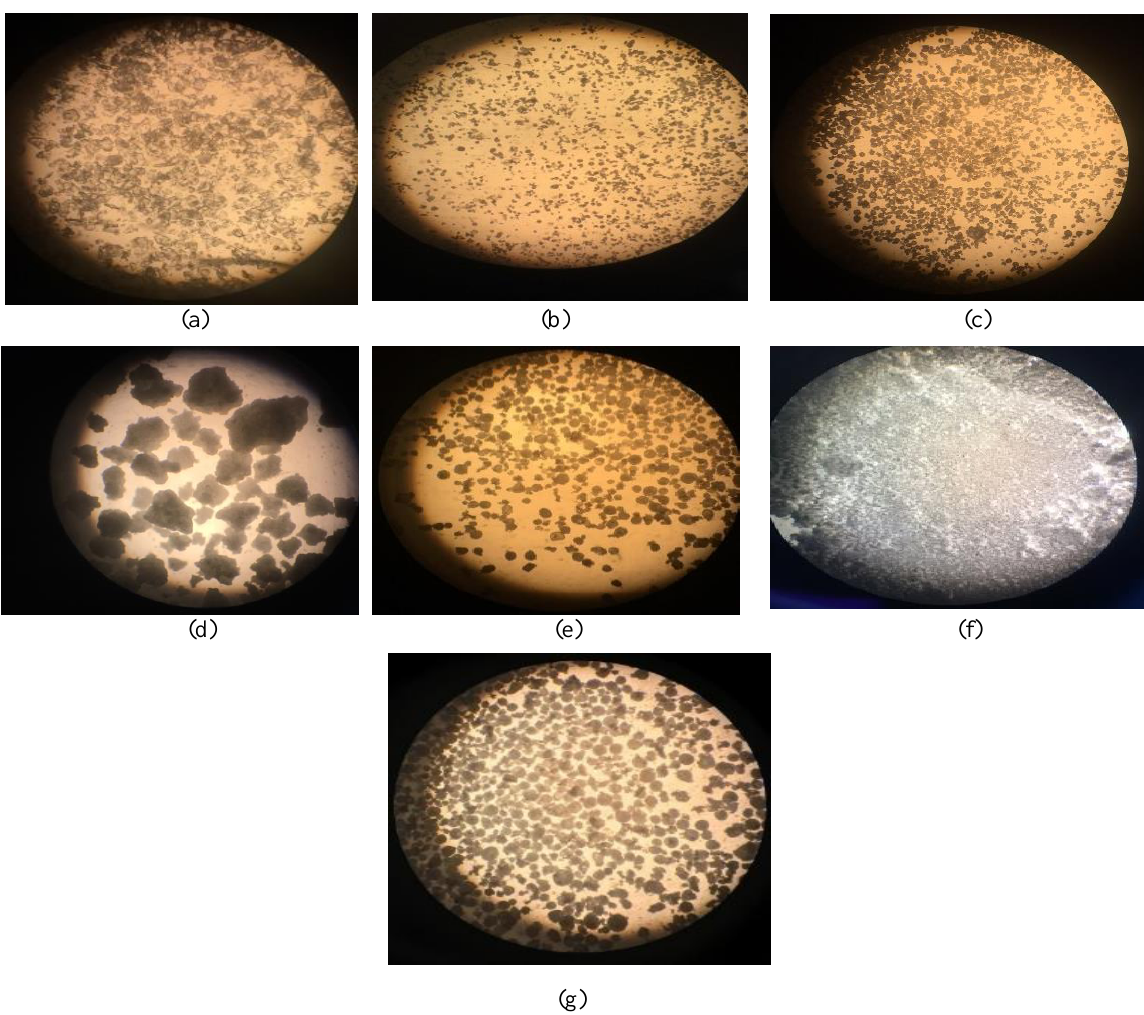
Figure 1. Optical microscope of pure drug and formulated SCAs (a)pure drug, (b)EBS1, (c)EBS2, (d)EBS3, (e)EBS4, (f)EBS5,